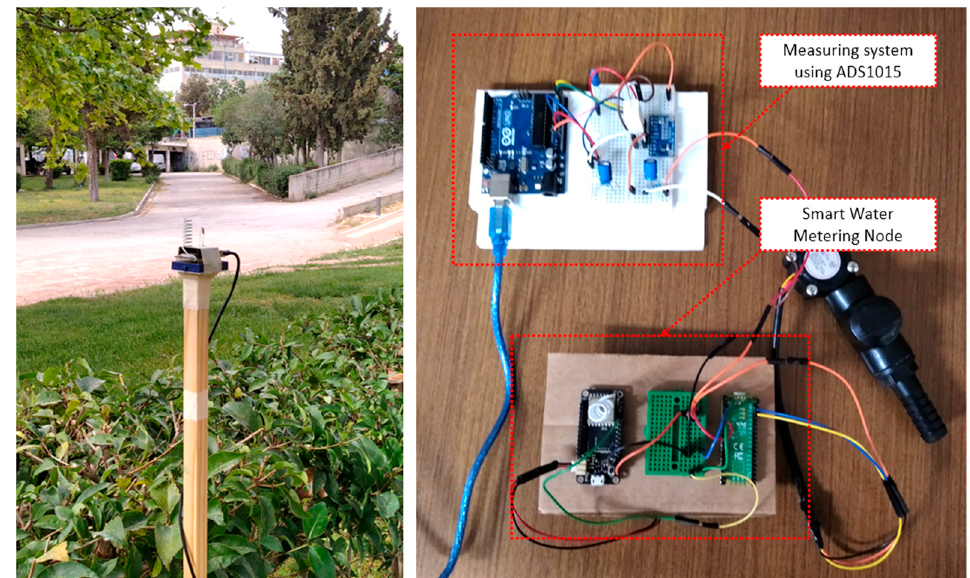
Figure 8. Experiments for testing the range coverage ( left ) and the energy consumption ( right ) of the prototype sensor nodes.